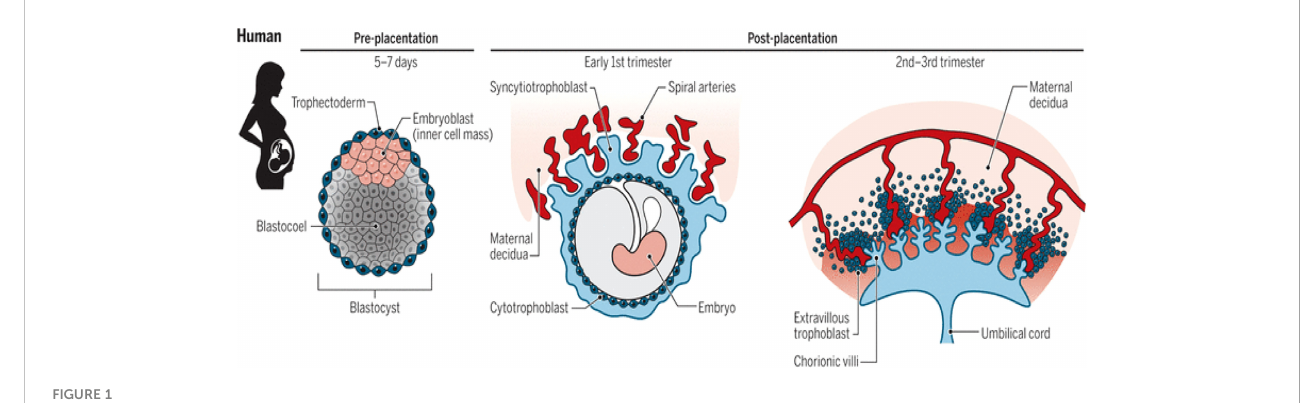
FIGURE 1 Stages (pre-and post-placentation) of placenta development